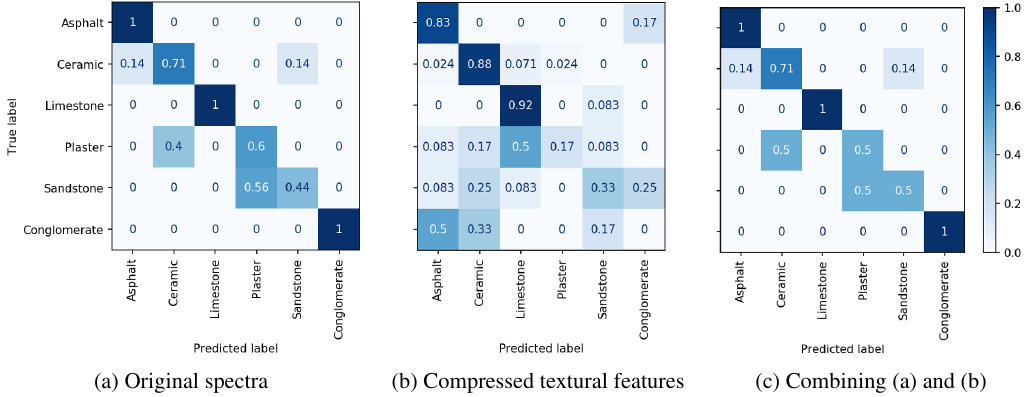
Figure 8. Confusion matrix for the classification results of the RF classifier using: (a) the original spectra, (b) the compressed textural features of the image patches and (c) the combination of the original spectra and the textural